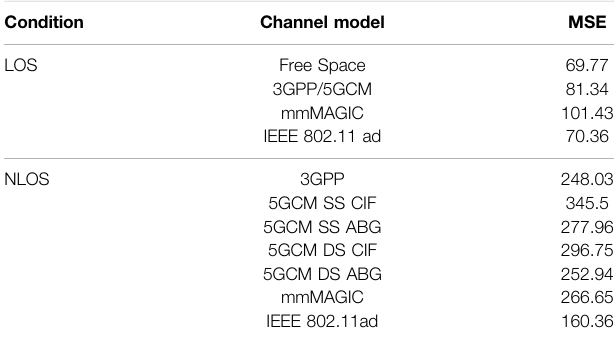
TABLE 6 | MSE values obtained from each channel model for the of fi ce corridor environment.